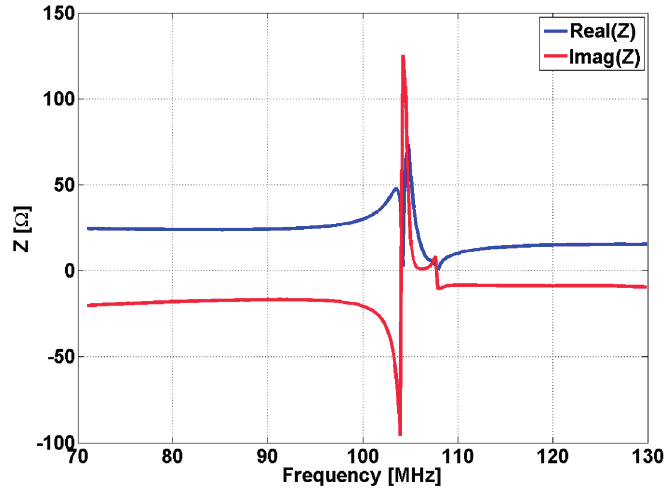
Figure 4. The dependency by frequency of CSR impedance.